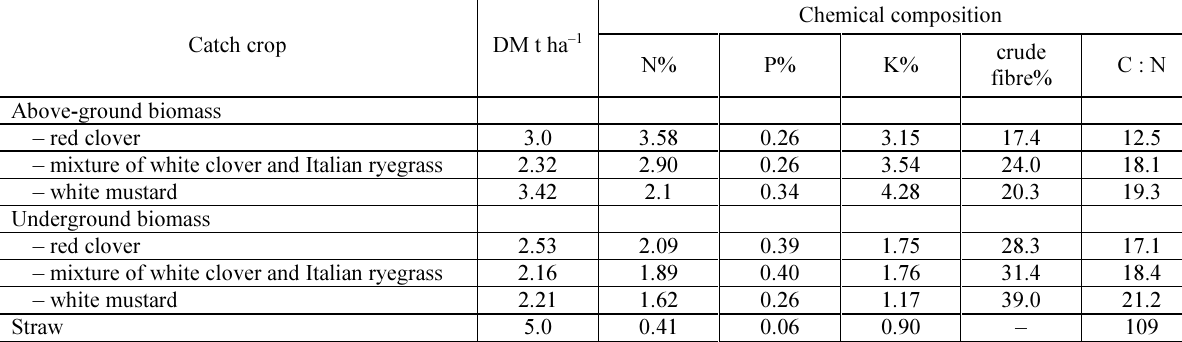
Table 1. Biomass of catch crops and straw incorporated into the soil and their